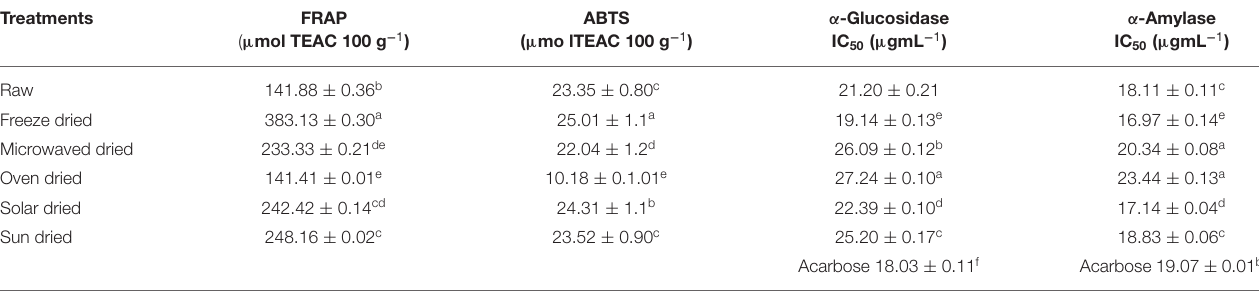
TABLE 4 | Effect of different drying treatments on antioxidant activities and inhibitory effect on digestive enzymes in the leaves var. Butternut squash ( C. moschata ). Treatments